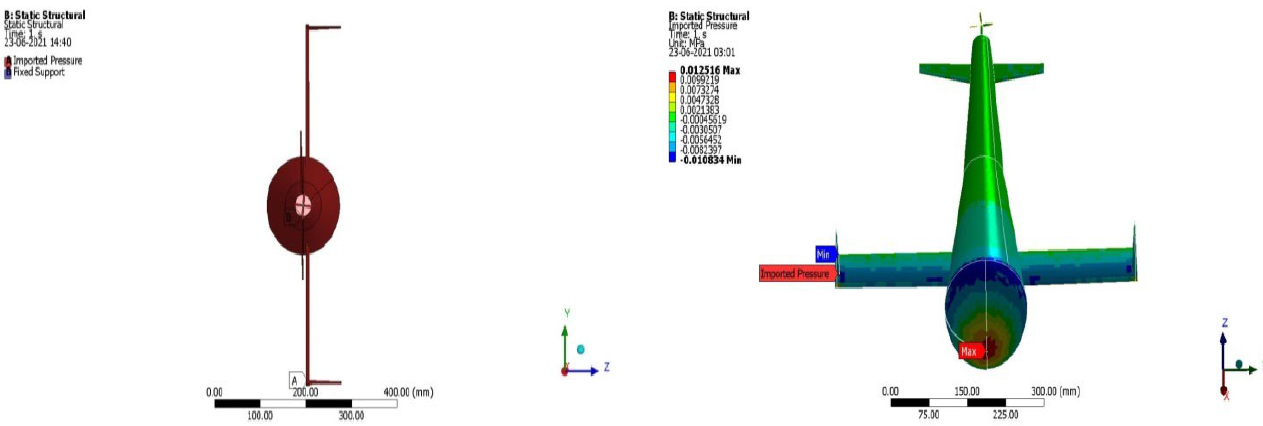
Figure 37. Boundary conditions imposed in optimised UAV.